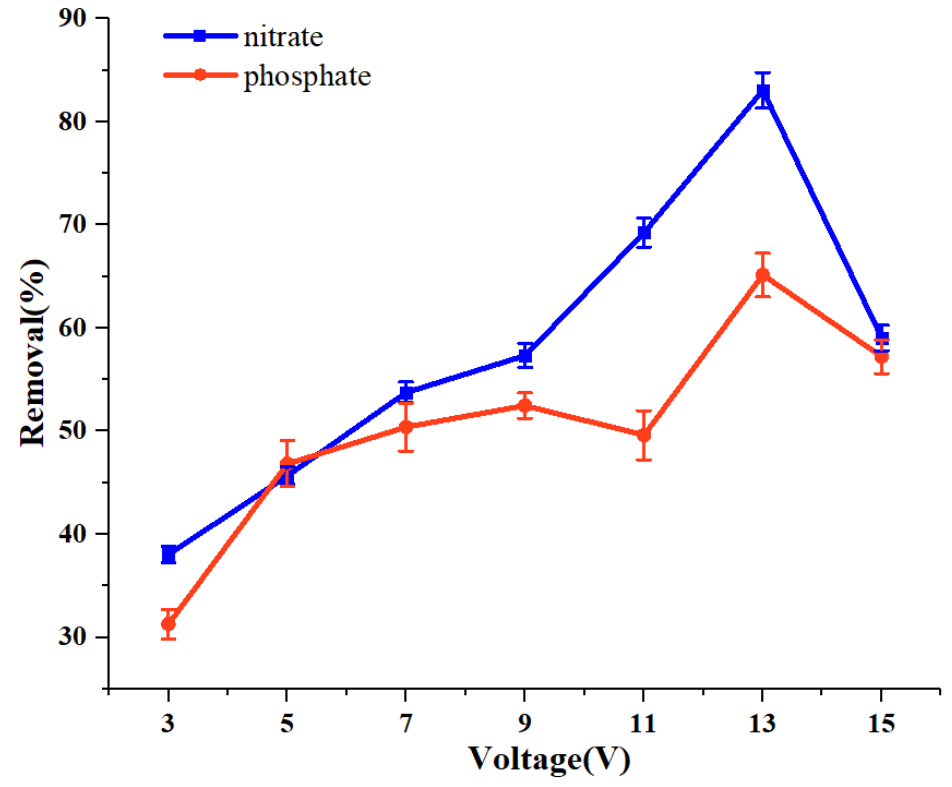
Figure 6. Effect of voltage on the removal efficiency of nitrate and phosphate.